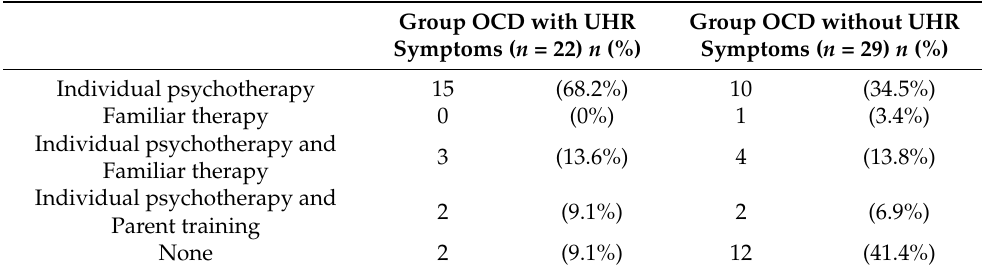
Table 3. Frequency and percentage of non pharmacological treatment scores separately for two